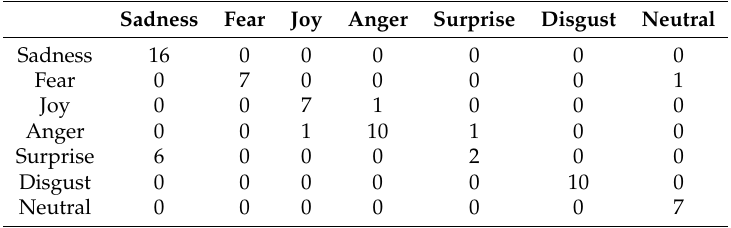
Table A25. A8 actor confusion matrix from the Emo-DB in the third phase.